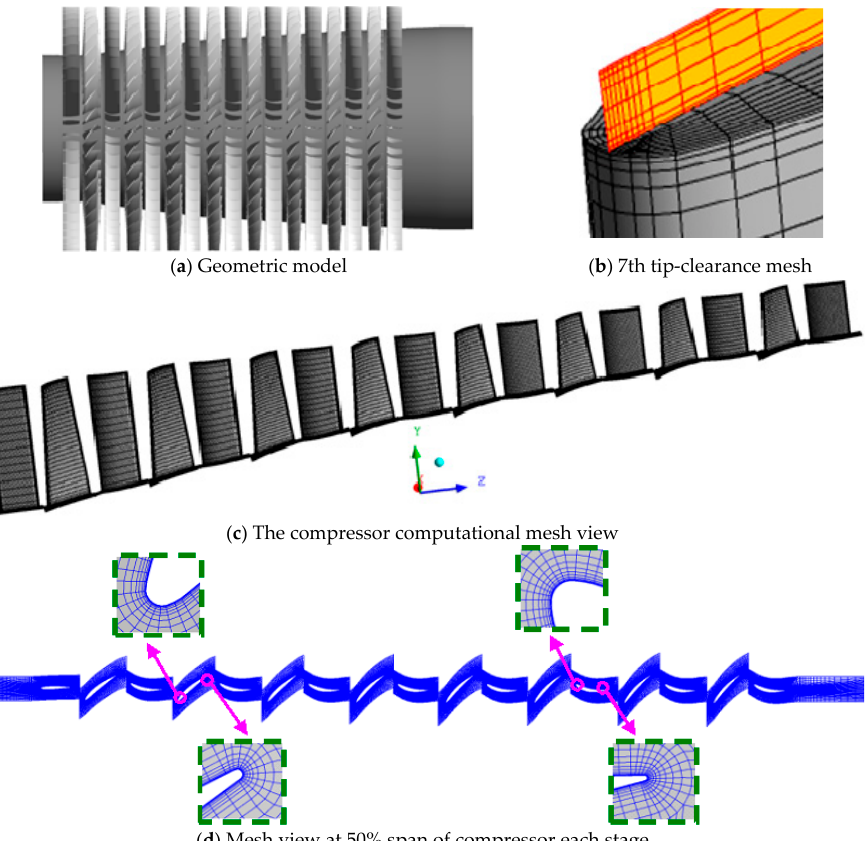
Figure 3. Computational geometric model and grids. Table 1. Computational element numbers of each compressor stage.